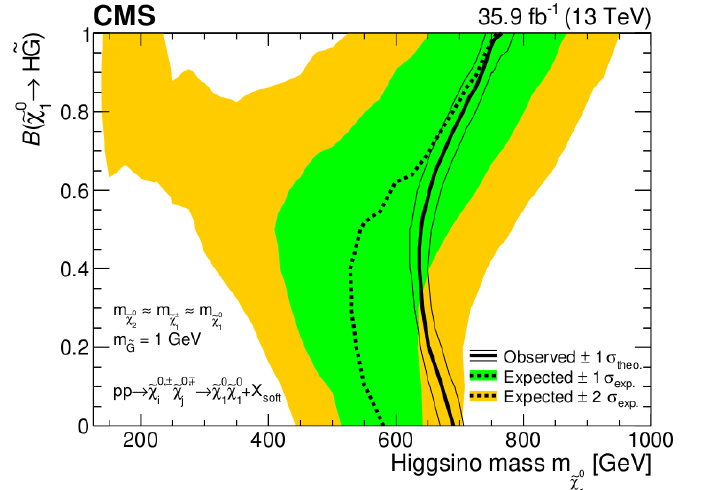
Figure 11 . Combined exclusion contours at the 95% CL in the plane of m for the model of (cid:31) 0 (cid:31) 0 production. The area to the left of or below the solid (dashed) black curve 1 1 represents the observed (expected) exclusion region. The green and yellow bands indicate the (cid:6) 1 and 2 (cid:27) uncertainties in the expected limit. The thin black lines show the e(cid:11)ect of the theoretical e e uncertainties ( (cid:6) 1 (cid:27) theory ) on the signal cross